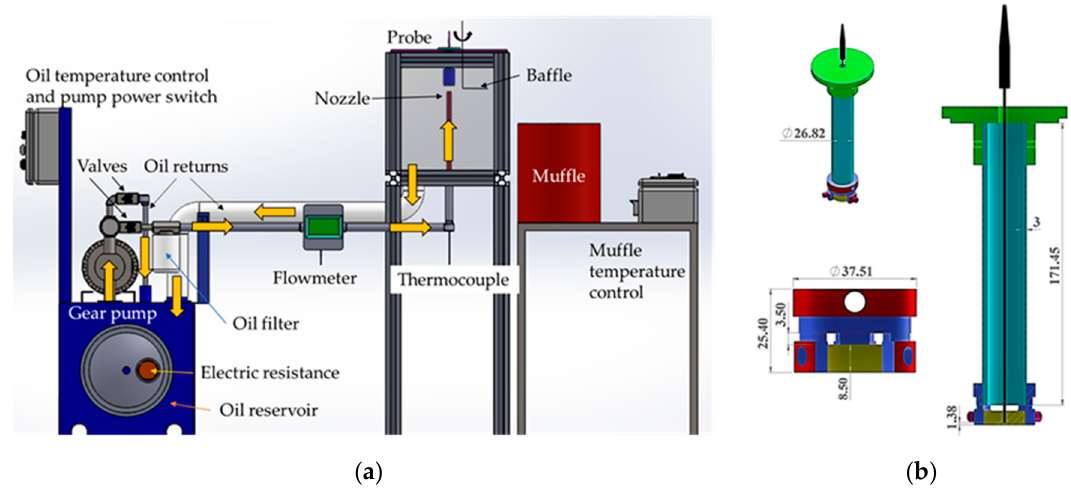
Figure 4. ( a ) Schematic representation of laboratory oil closed-loop for determination of the rate of heat removal during oil-quenching steel samples; ( b ) detailed view of the probe that holds a steel disc (marron color) and with sub-superficial thermocouple (black color). Dimensions are in mm.